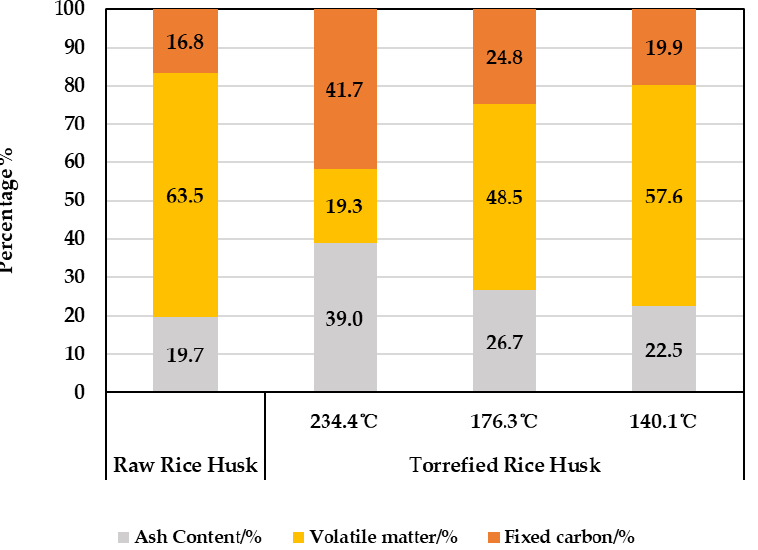
Figure 11. Comparison of weight residual rate between rice husks and torrefied rice husks.